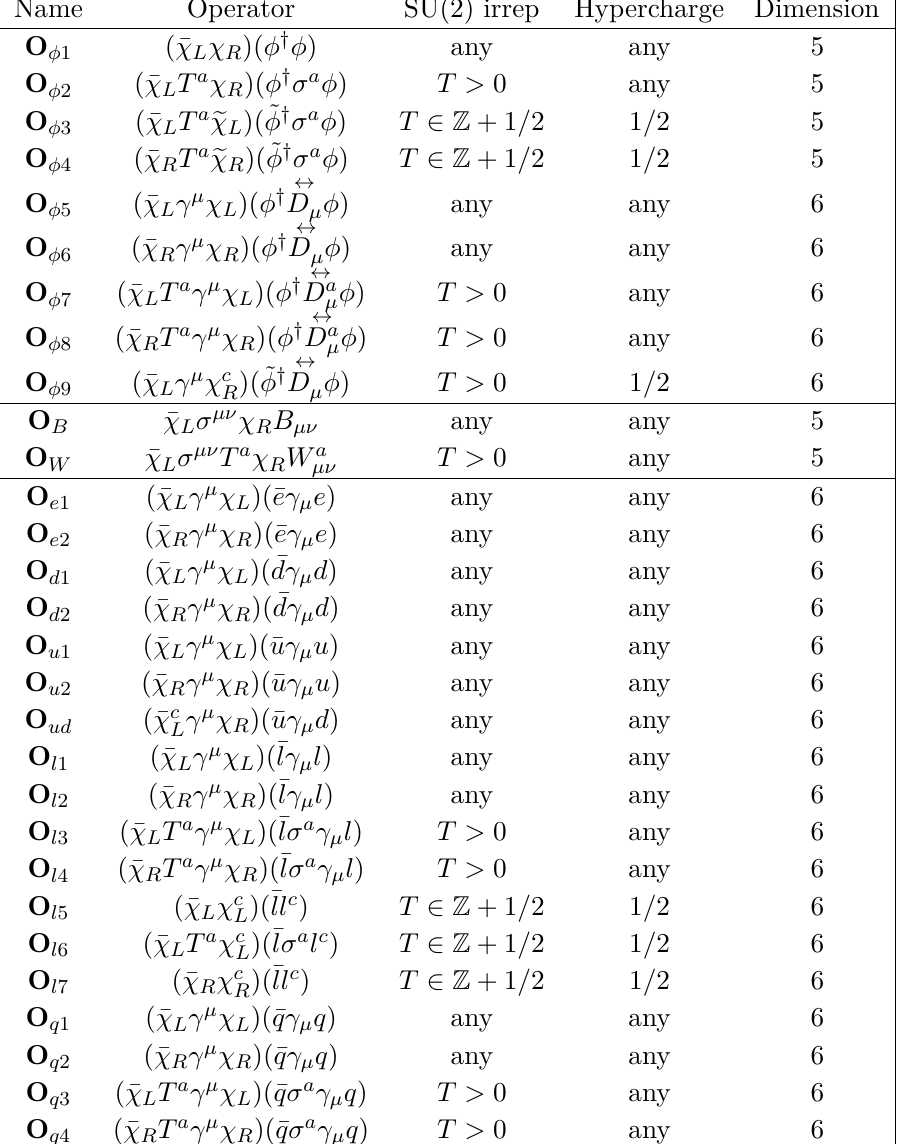
Table 6 . Basis of operators of dimension ≤ 6 with two fermion DM